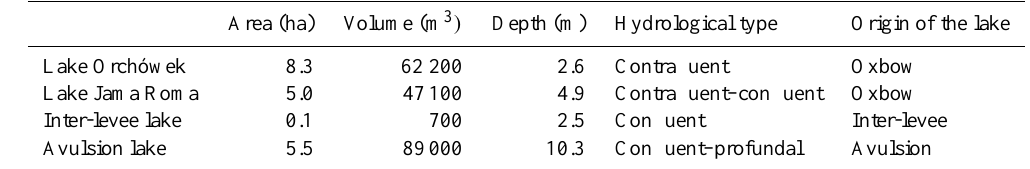
Table 1. Selected characteristics of the lakes under study.